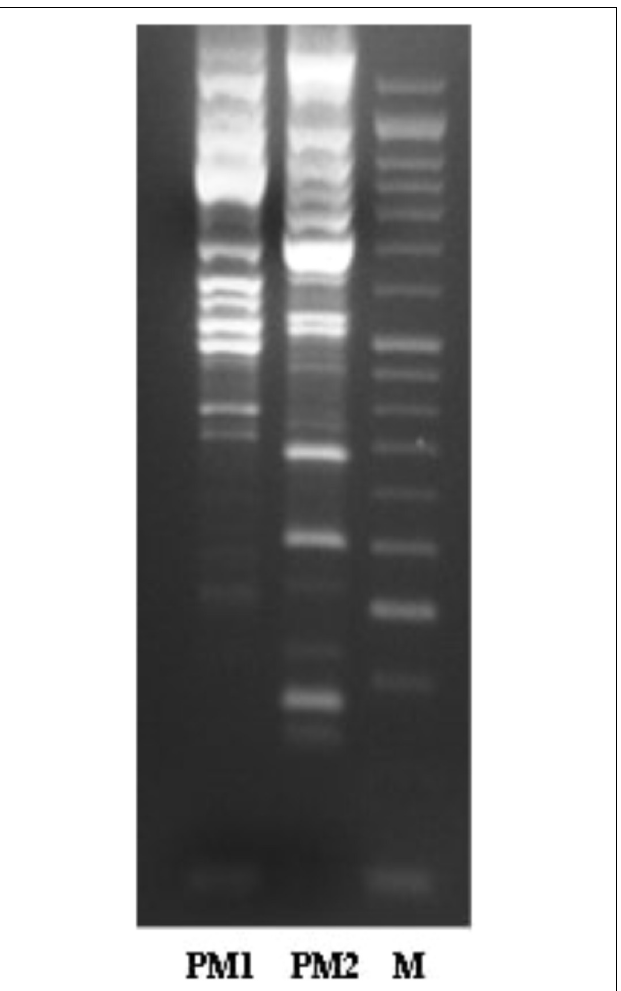
FIGURE 1 | Molecular profiles obtained by RAPD-PCR for PM1 and PM2.